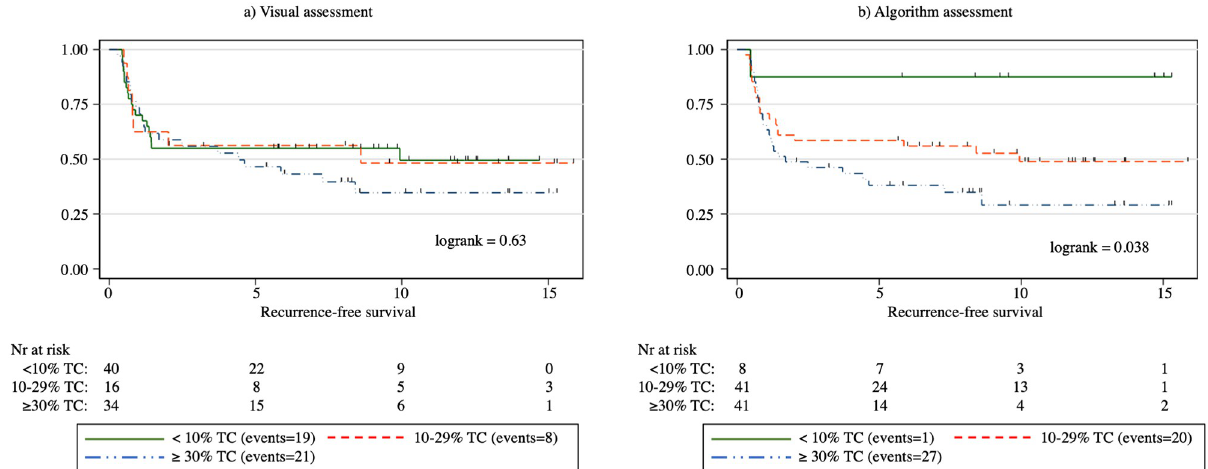
Fig 5. Kaplan–Meier curves for relapse-free survival (RFS) among patients with papillary thyroid cancer according to tall cell percentage thresholds: < 10%, 10–29%, and � 30% based on a) visual assessment and b) algorithmic assessment. In the figure, tall cell is abbreviated as TC.